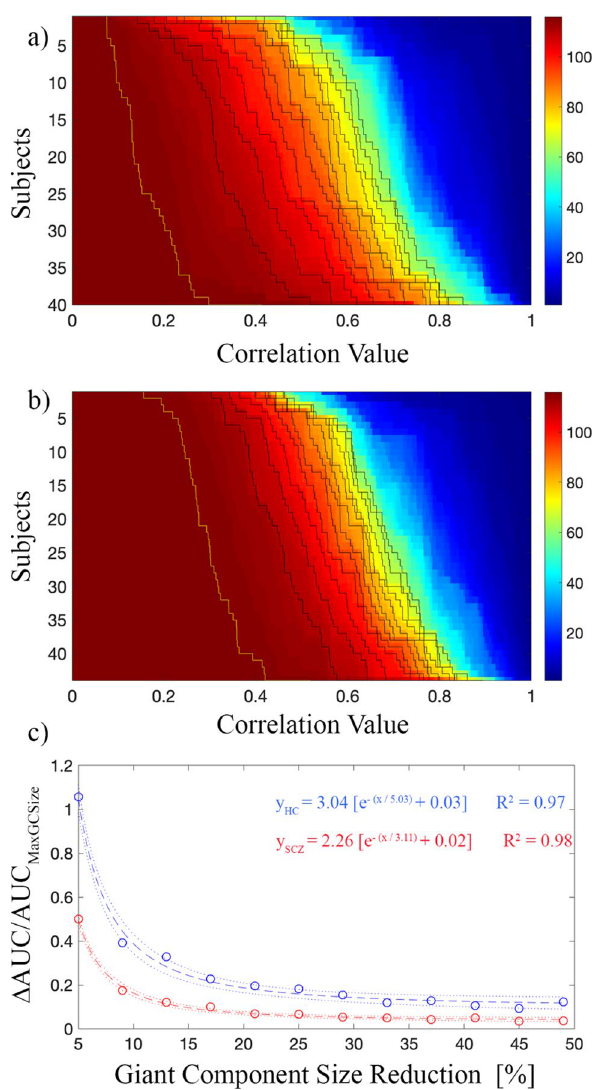
Figure 5. Percolation and giant component analysis. ( a ) Giant component size variation for HC, ( b ) giant component size variation for SCZ, and ( c ) the difference between the areas under two consecutive curves, ∆AUC, normalized to the area under the curve associated with the maximum giant component size, AUC MaxGCSize (yellow line), for HC (blue) and SCZ (red). ∆AUC/AUC MaxGCSize , for different values of the giant component size reduction, was fitted to the exponential decay. The speed of decay (SoD) was found to be SoD HC = (5.03 ± 0.02) and SoD SCZ = (3.11 ± 0.01) for HC and SCZ, respectively. Dotted lines represent 95% of prediction